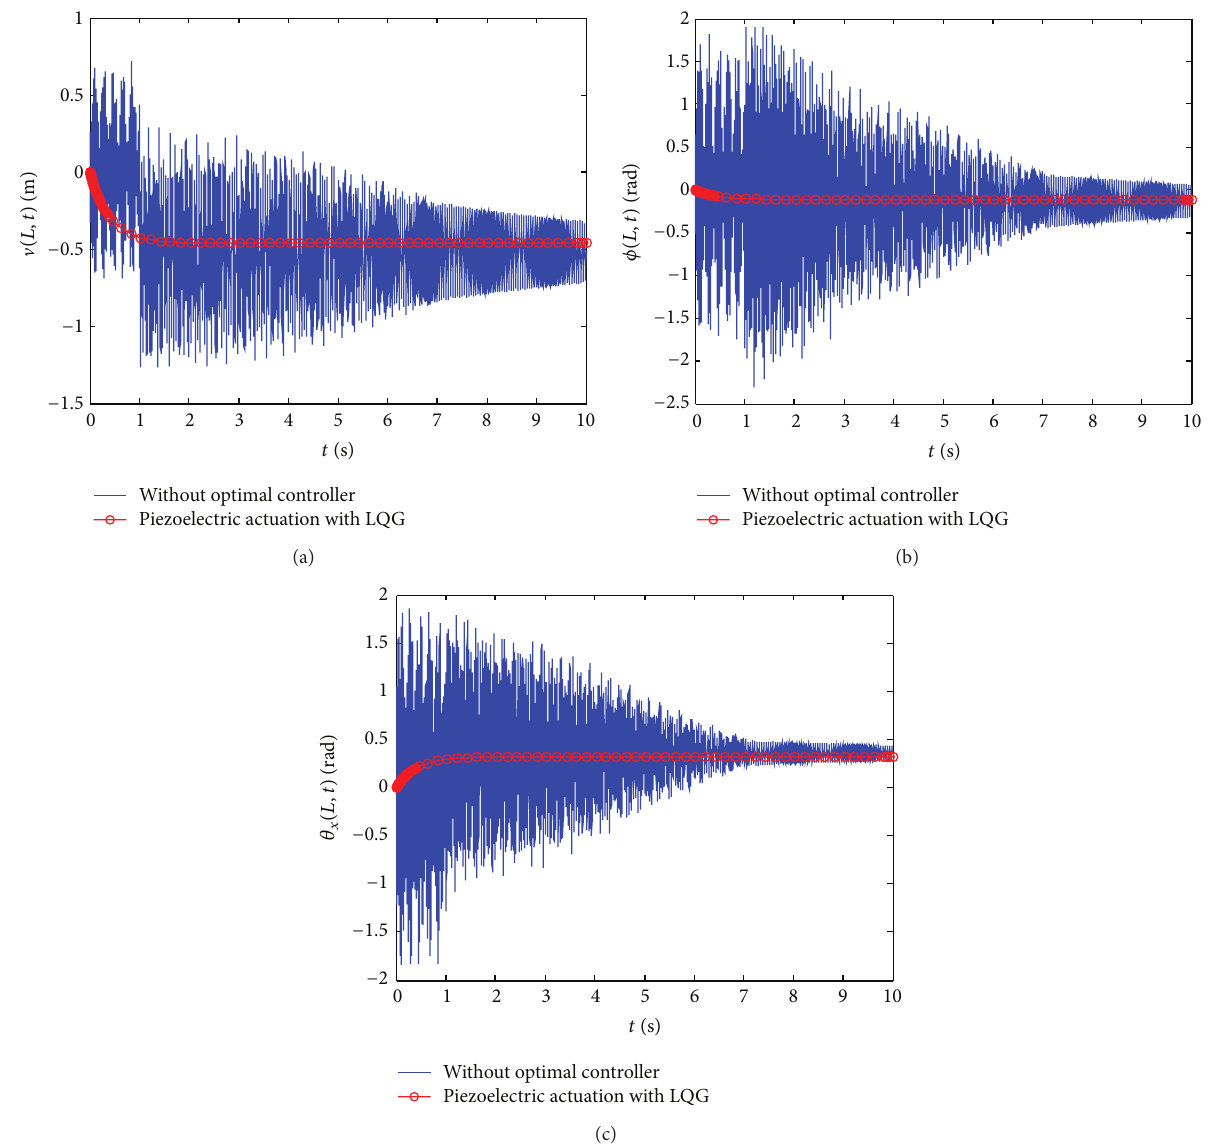
Figure 4: The responses of the three displacements under condition of fixed feedback gains of 𝑘 V = 1 and 𝑘 𝑎 = 1 , which are characterized by the state without optimal controller (in blue mark) and LQG controller (in red mark) for 𝑈 = 34.69